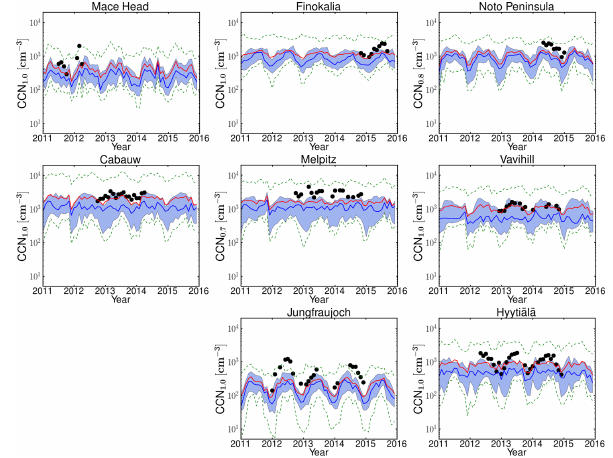
Figure 4. Same as Fig. 2 for the CCN at the maximum supersatura- tion with available measurements at each station. For Puy de Dôme only CCN 0 . 2 data are available and are shown in Fig.